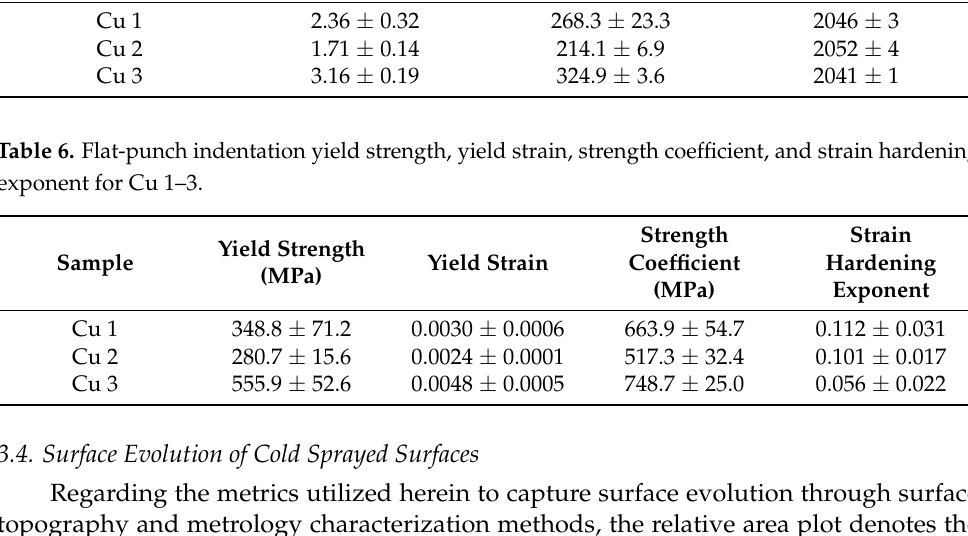
Table 5. Flat-punch indentation hardness, the applied load, and the indentation depth for Cu 1–3. Sample